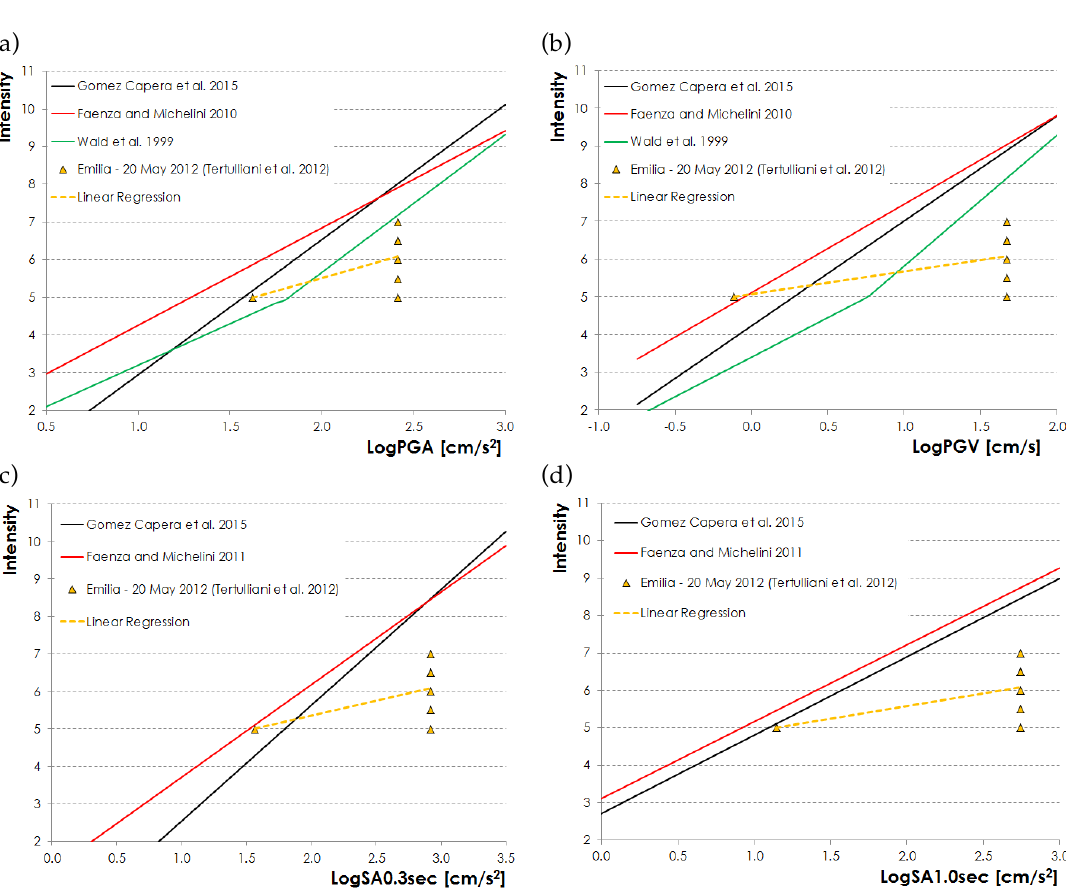
Figure 4: Comparisons between I for the 20 May 2012 Emilia first mainshock (Tertulliani et al. 2012) and predicted EMS MCS values from literature models based on PGA (a), PGV (b), SA(0.3) (c) and SA(1.0) (d)